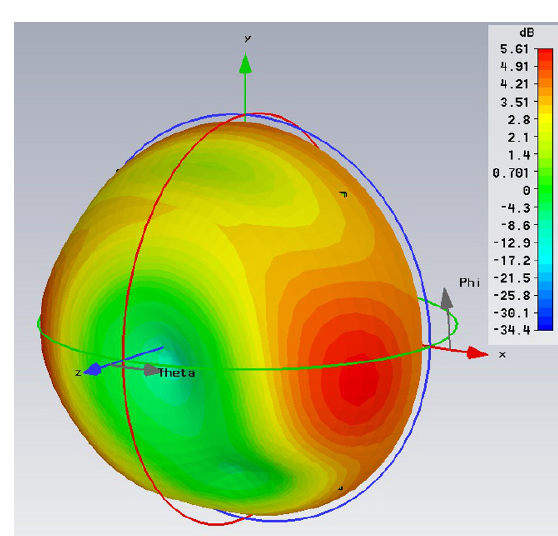
Figure 9. Radiation pattern for LPA.